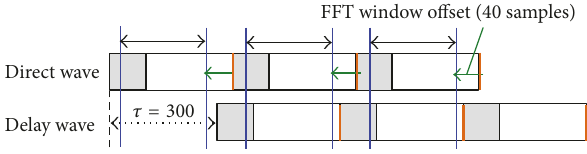
Figure 8: Adjustment of FFT